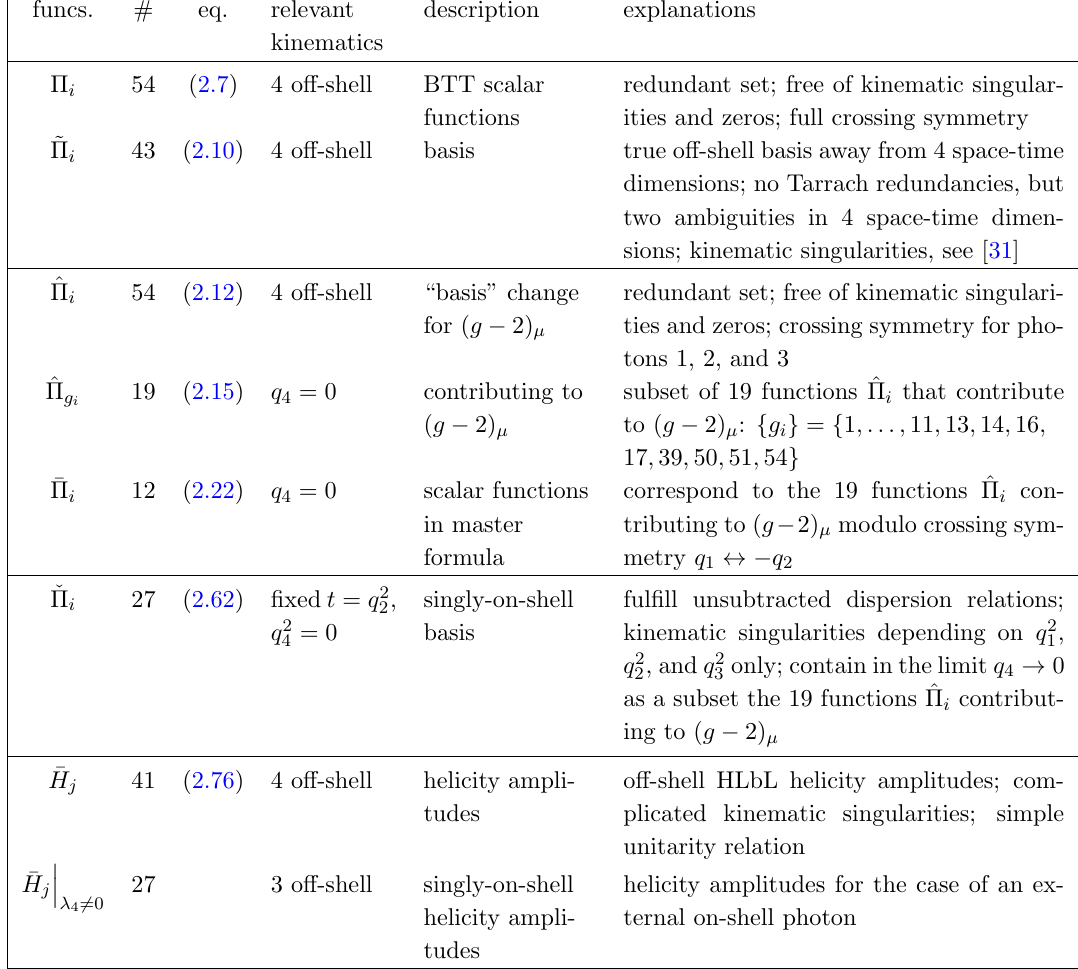
Table 1. Scalar functions appearing in the formalism for the two-pion HLbL contribution to ( g